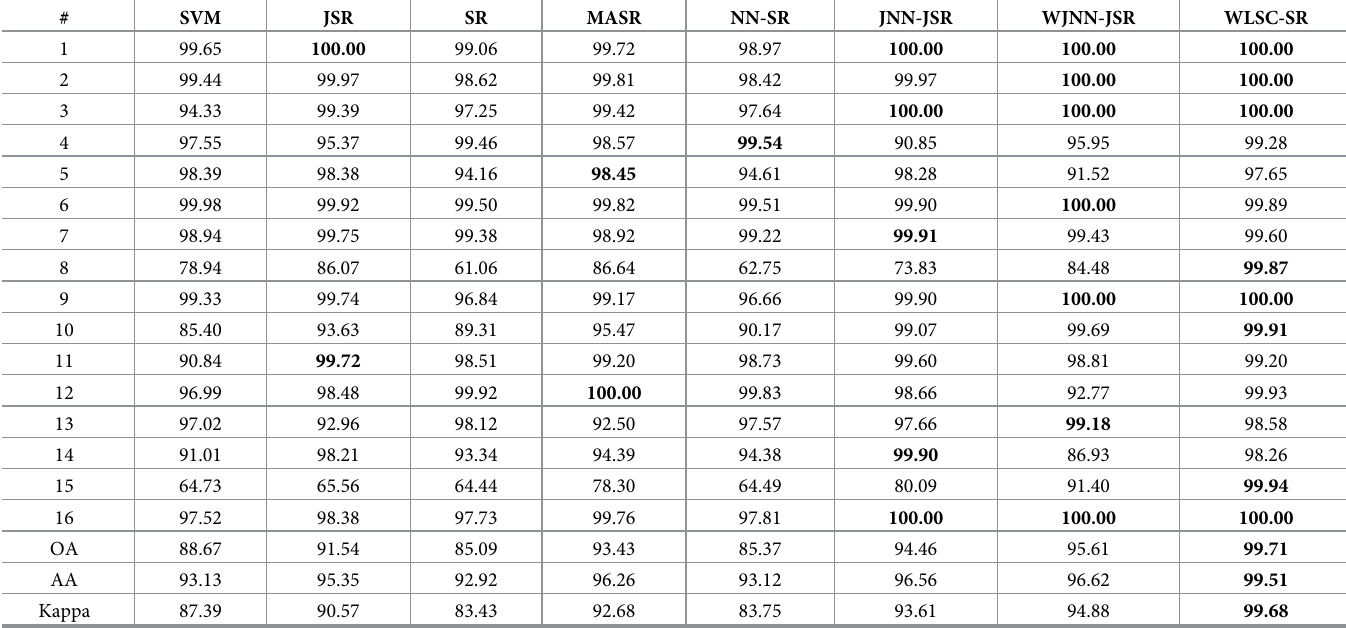
Table 4. Classification accuracy (in percent) of the Salinas scene in the SVM [1], JSR [17], SR [16], MASR [19], NN-SR [18], JNN-JSR [27], WJNN-JSR [27], and